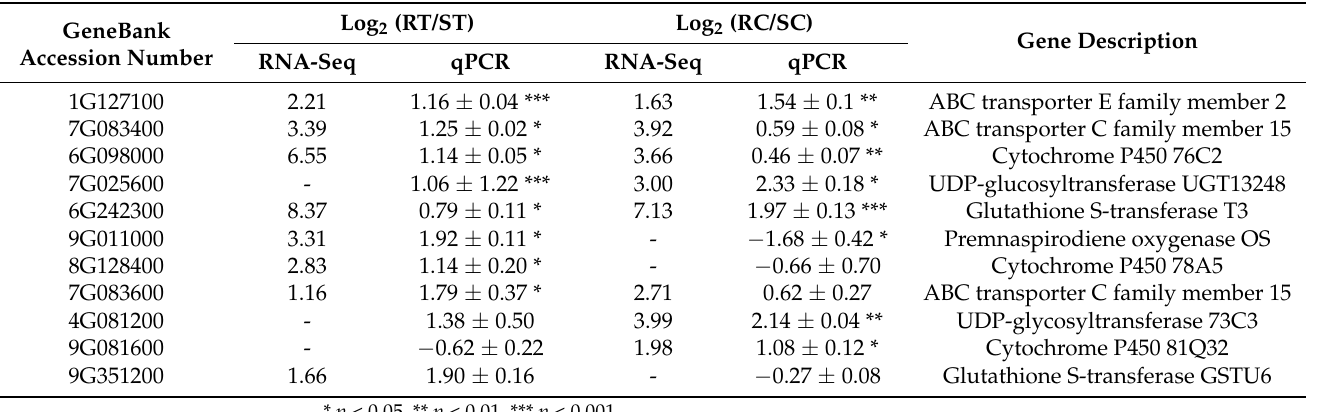
Table 5. The candidate differentially expressed genes related to non-target-site resistance of S. viridis to nicosulfuron.